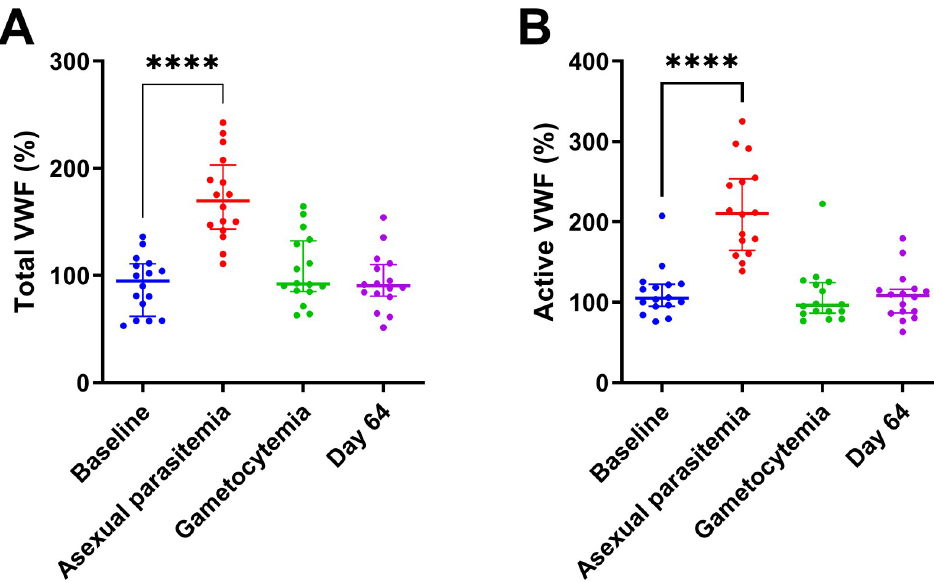
Fig 3. Plasmodium falciparum infection increases VWF and active VWF levels. (A-B) Total VWF (A) and active VWF (B) levels were quantified by ELISA and presented as the percentage of a pooled normal plasma standard. Results are shown as the median and interquartile range, and ���� indicates a p-value below 0.0001.